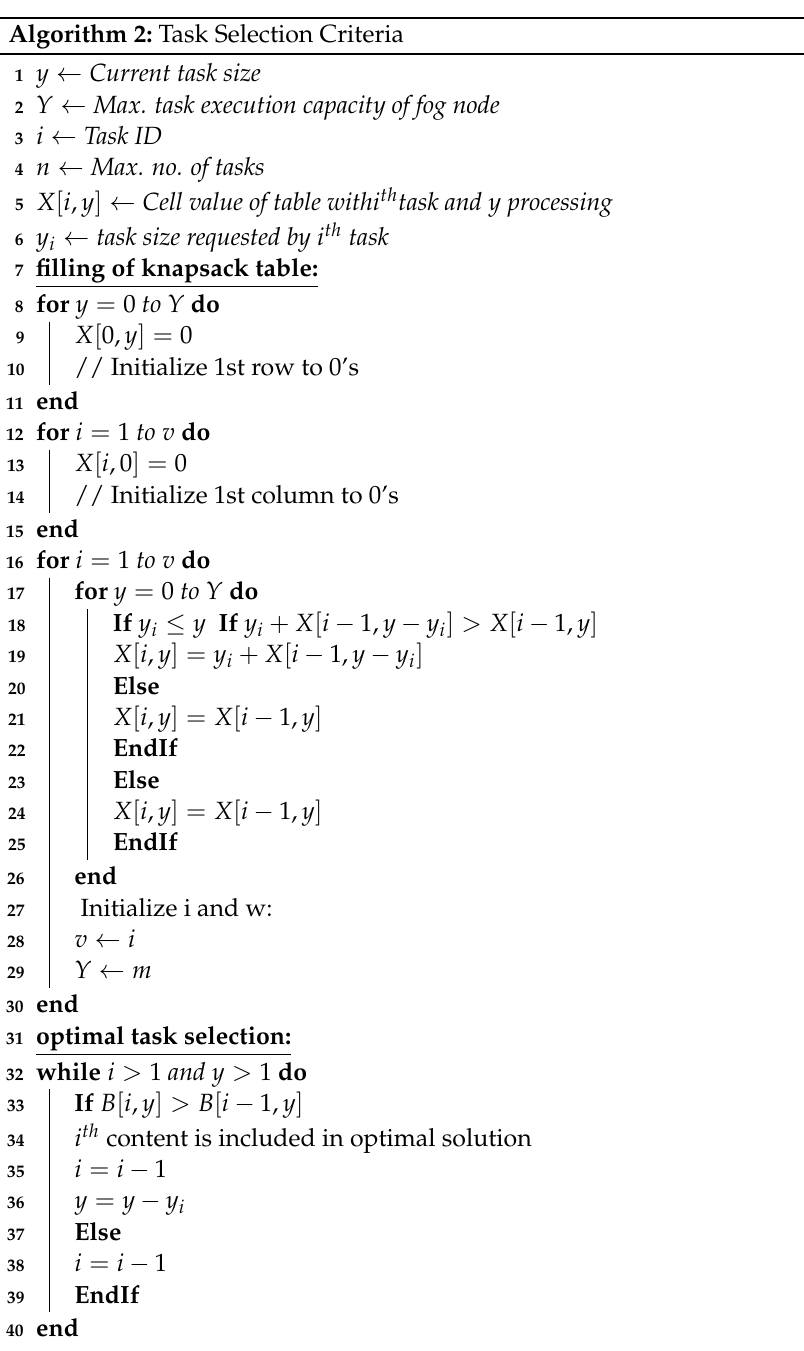
Algorithm 2: Task Selection